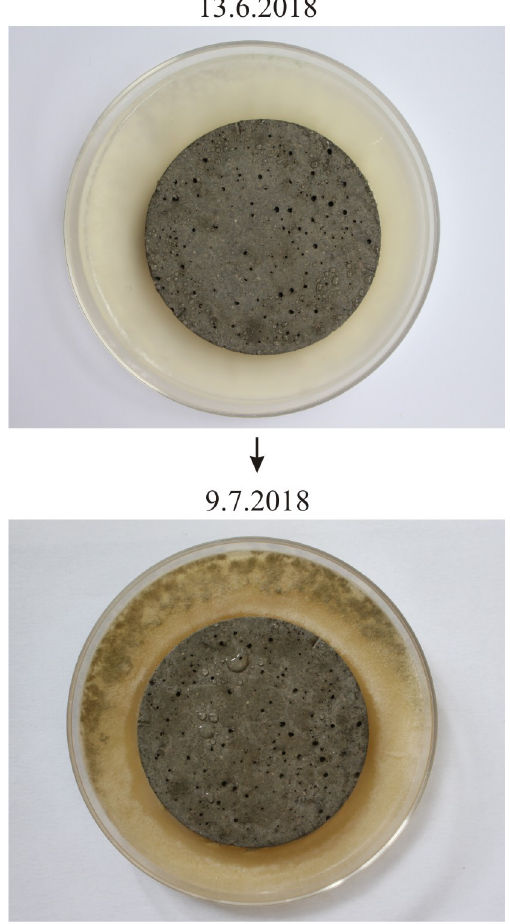
Figure 7. Development of fungus Trichoderma reesei .